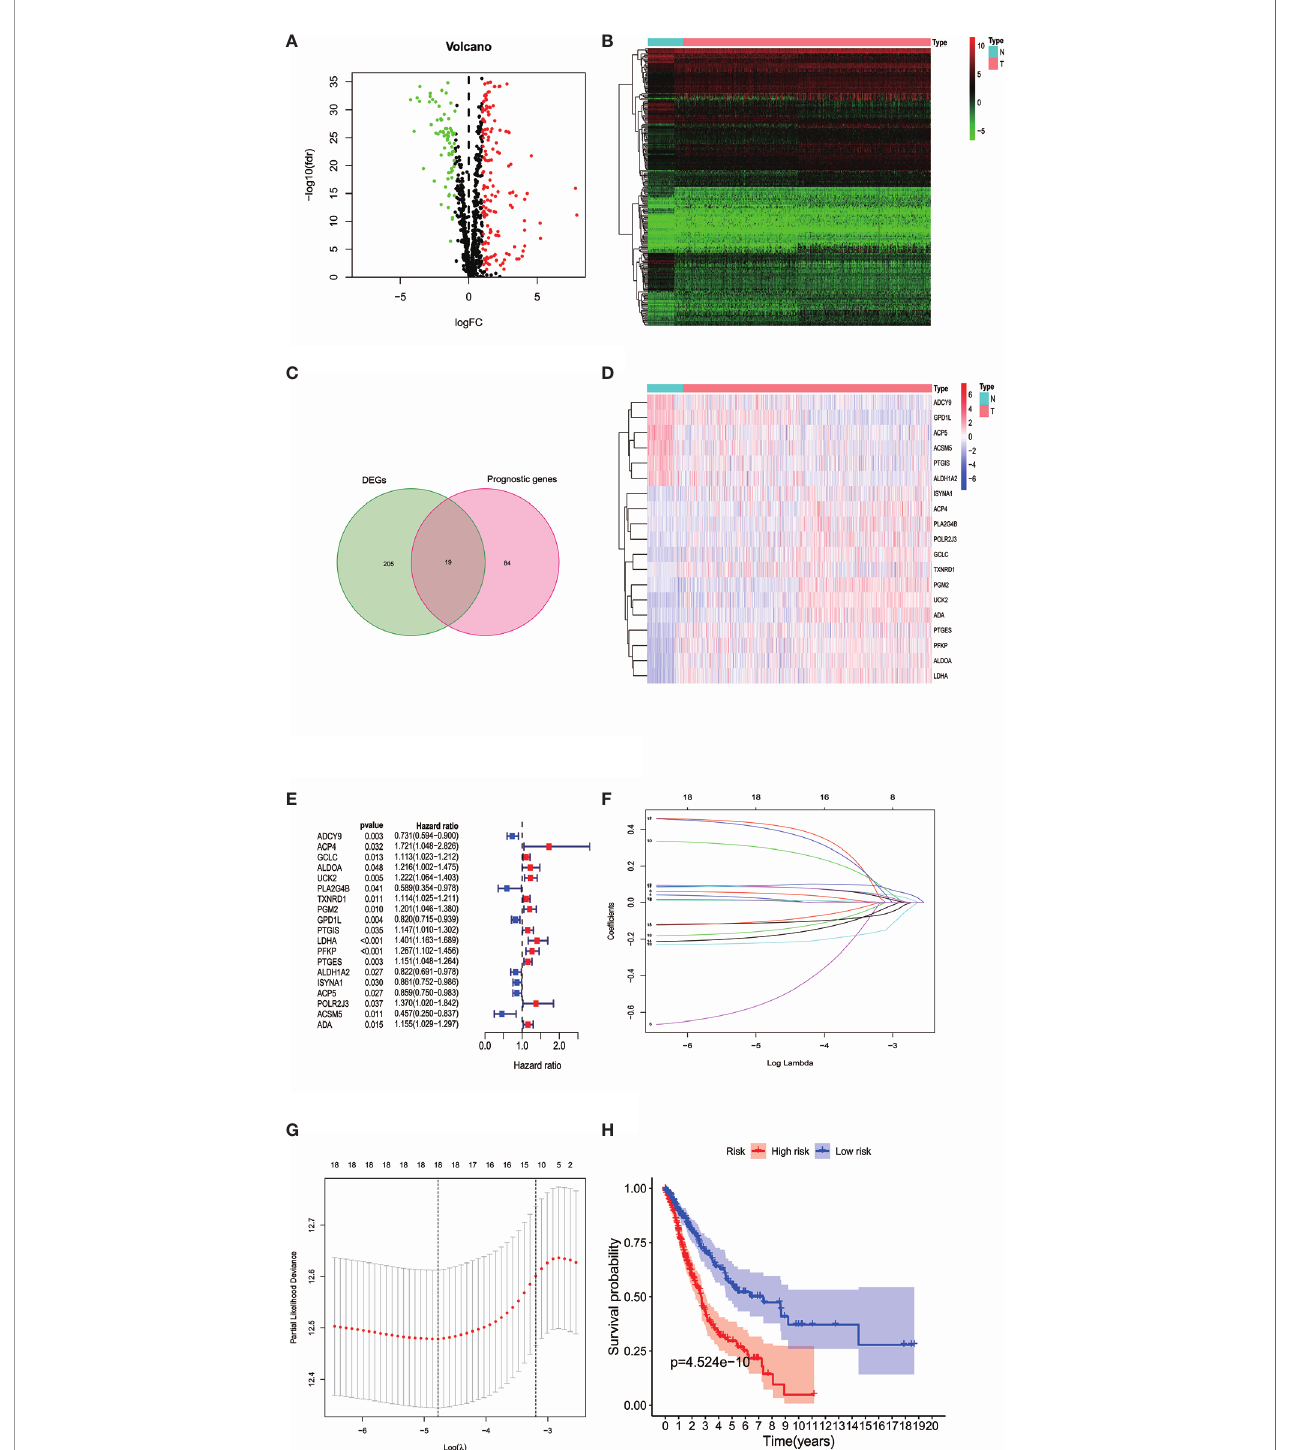
FIGURE 1 | (A) The volplot of DEMGs between tumor and normal tissues. The red plots represent up-regulated genes and the green plots represent down- regulated genes. (B) The heatmap of DEMGs between tumor and normal tissues. N represents normal tissues and T represents tumor tissues. (C) The intersection of DEMGs and the prognostic genes were generated. A total of 19 intersection genes were identi fi ed. (D) The heatmap of the 19 intersection genes. (E) The 19 intersection genes that related to OS were extracted by univariate Cox regression analysis. (F, G) The LASSO Cox regression analysis were performed with the optimal value of l . (H) The survival analysis revealed the high-risk patients were associated with poor